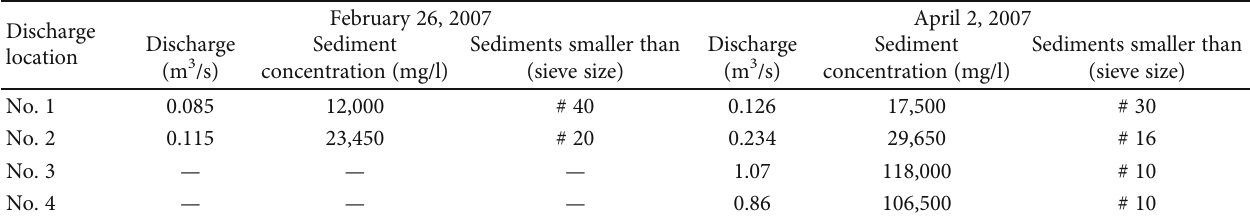
Table 5: Overtopping fl ow/seepage discharge and sediment concentration